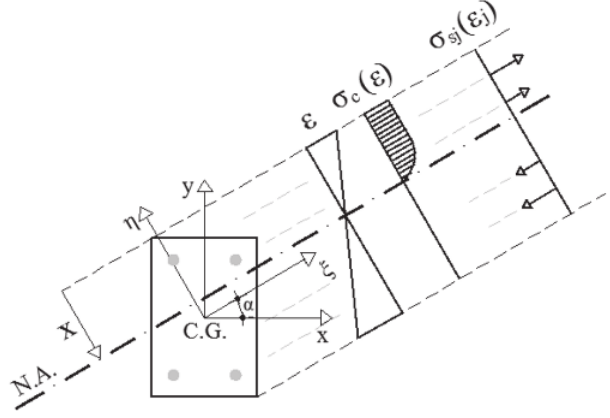
Figura 3 Estado de deformação definido para uma dada profundidade e inclinação da L.N